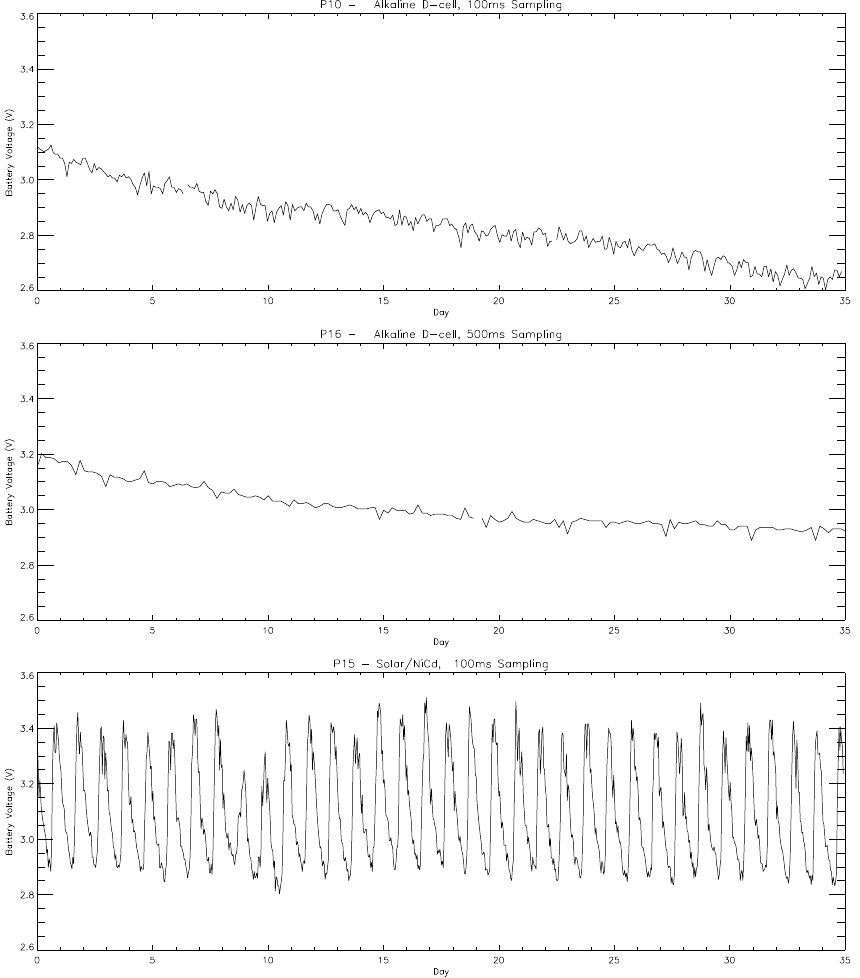
Fig. 6. Battery voltage at the start of each datafile recorded by the three sensors in April 2012. Note the steep initial decline (compare with Fig. 2) for the top two alkaline-only units. Note the slower decline for P16, with the lower sample rate. The lowest unit shows a generally uniform diurnal cycle, although peak voltage dropped on days 9 and 10 due to